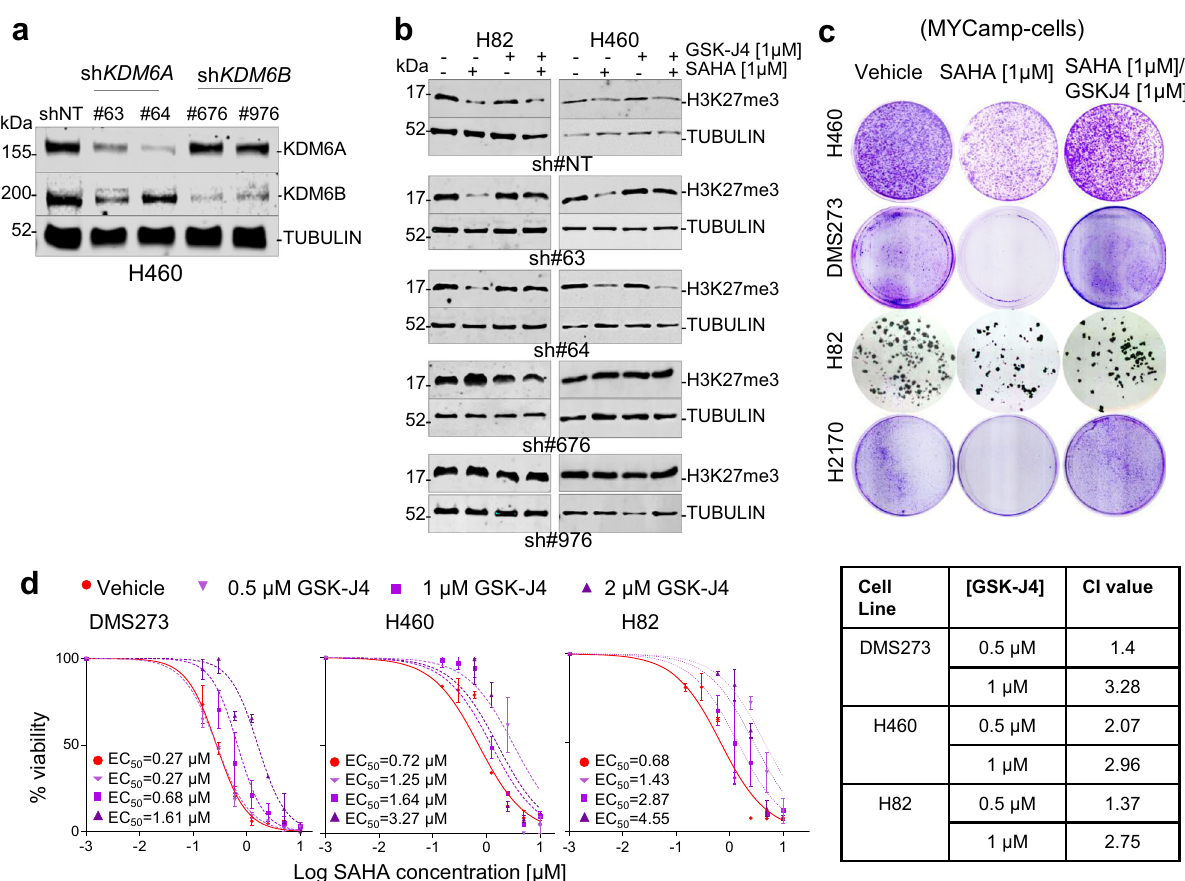
Fig. 3 KDM6B depletion mimics the response of SMARCA4-de fi cient cells to SAHA. a Western blot depicting levels of KDM6s in H460 cells infected with the non-target short hairpin (shNT) and with different shKDM6A (#63 and #64) and shKDM6B (#676, #976). b Western blot depicting levels of H3K27me3 and cells infected with the shNT, shKDM6A (#63, #64) or shKDM6B (#676, #976) treated with GSK-J4 and/or SAHA for 72 h. c Representative clonogenic assays for the indicated cells and treatments. d Viability of indicated cell lines, measured using MTT assays, 5 days after treatment with increasing concentrations of SAHA and co-treated or not with GSK-J4 at different concentrations. Lines, number of viable cells relative to the untreated cells. Data are presented as mean ± SD from three replicate cell cultures in two experiments. EC 50 , half-maximal effective concentration. On the right, table presenting the combination index (CI) at the indicated concentrations of GSK-J4 (average CI from two independent experiments). CI < 1, CI = 1 and CI > 1 indicate synergism, additive effect, and antagonism, respectively. A Source Data fi le is available for this fi